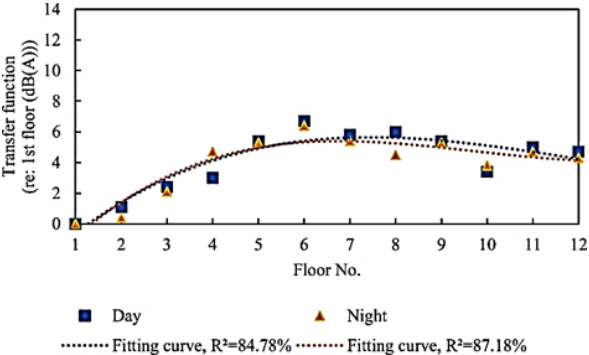
Figure 1: Transfer function between each floor and 1st floor (building A), (figure taken out of